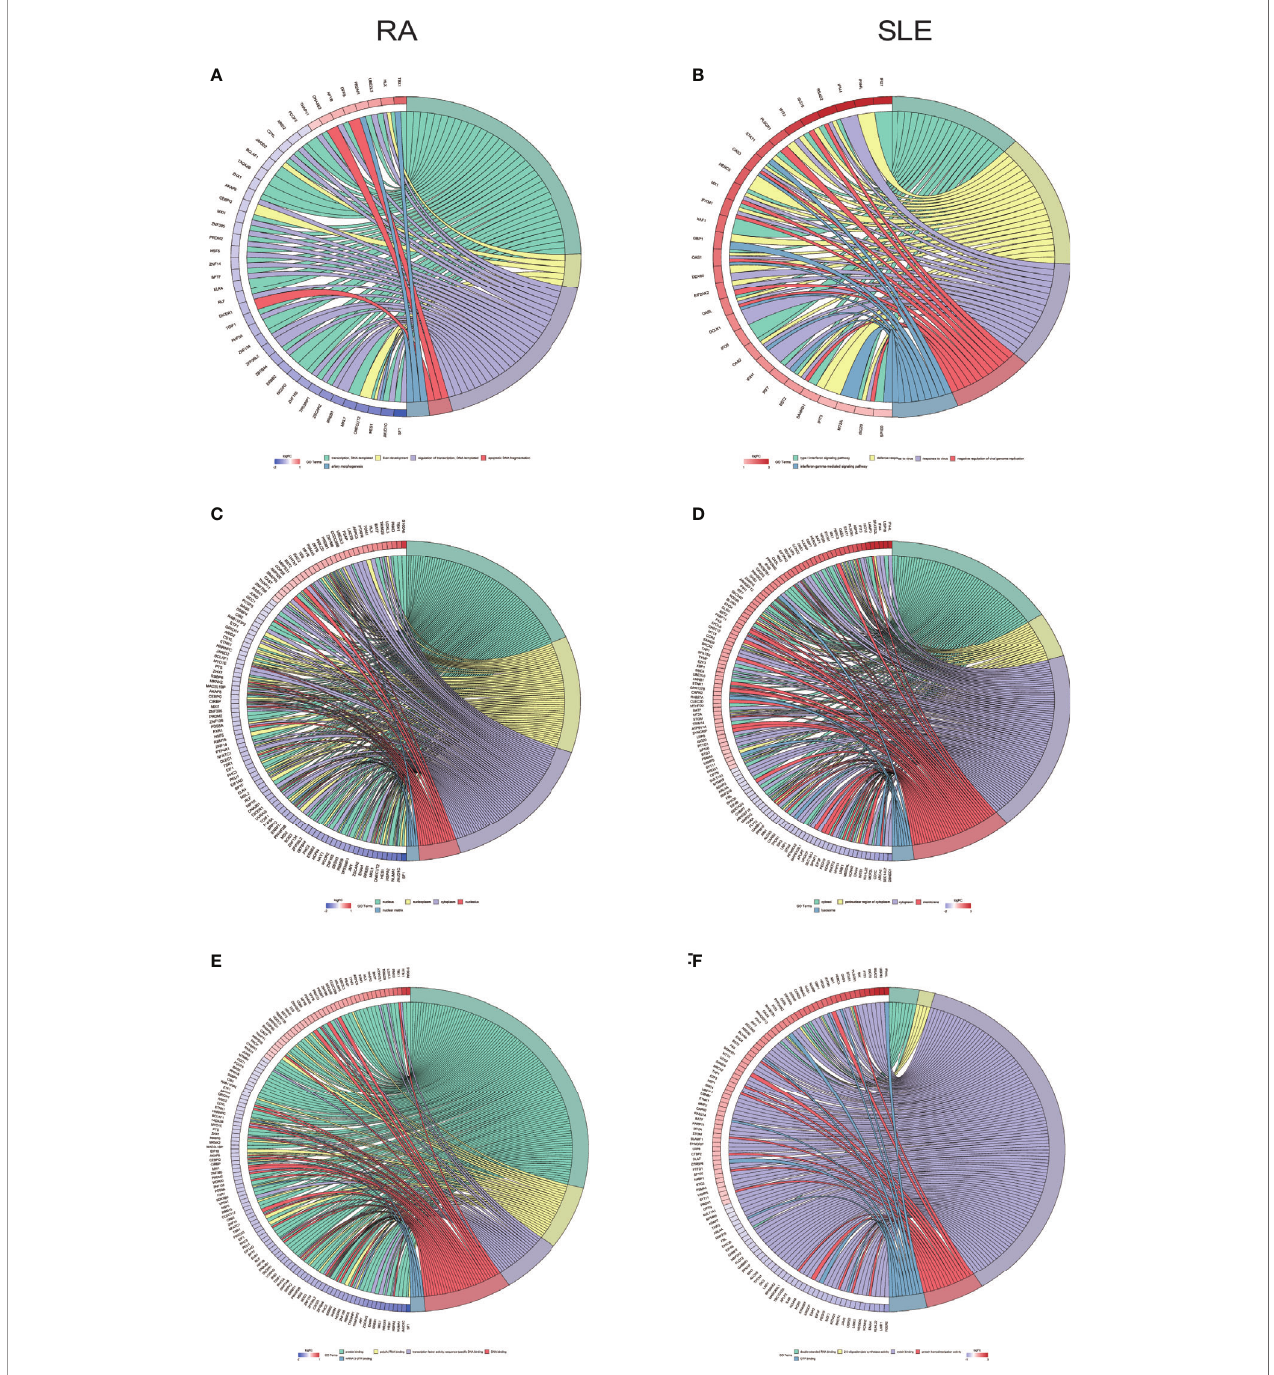
FIGURE 3 | Chordplotdepicting the relationship between aberrantly methylated DEGs ofCD19 + B cells between RA and SLE. (A) Top 5 GO terms of biologicalprocess in RA; and (B) SLE; (C) Top 5 GO terms of cellular components in RA and (D) SLE; (E) Top5 GO termsofmolecular functions in RA and (F) SLE. GO, Gene